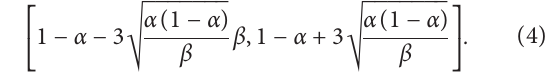
Figure 3: (a) z − z plane of 6D FWMHS attractors; (b) z 1 3 − z − z (d) z plane of 6D FWMHS attractors; (e) bifurcation diagram for control parameter e 1 3 4 parameter e 3